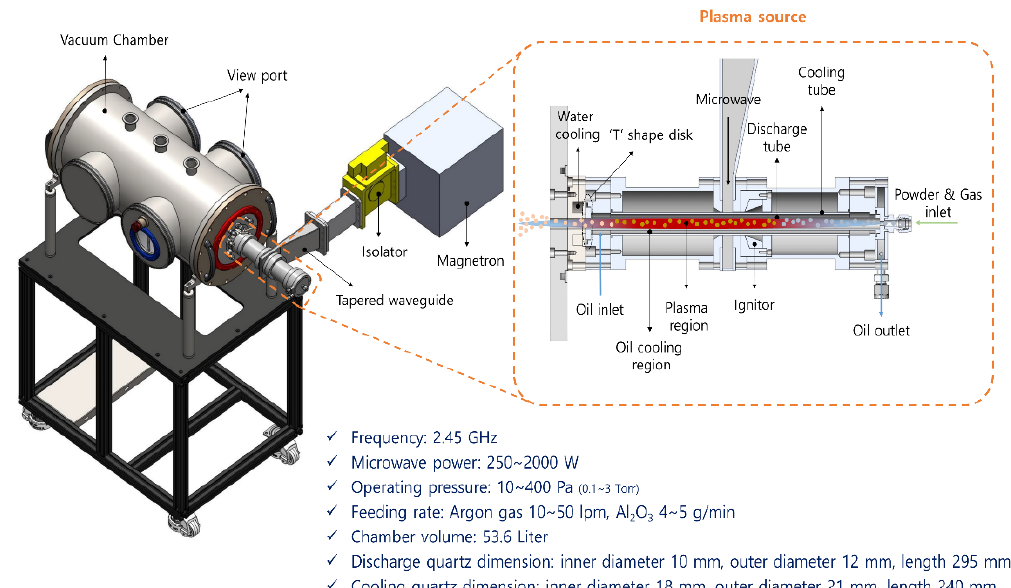
Figure 2. Schematic of the μ -PAD source. The 2.45 GHz microwave propagates through the tapered waveguide, while plasma ignition occurs inside the quartz discharge tube. Effective cooling is provided by silicon oil that surrounds the discharge tube, and water cooling at the ‘T’ shaped disk end.